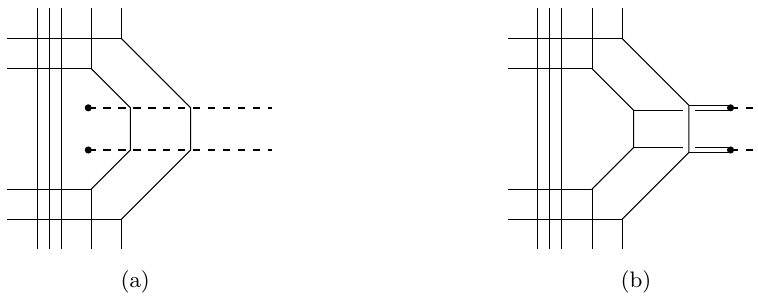
Figure 5 . Starting from the web shown in (cid:12)gure 4(a) and moving the 7-branes out of the web along their branch cuts produces 5-brane prongs stretching between the 7-branes and the 5-branes of the web, with avoided intersections due to the s -rule shown as broken